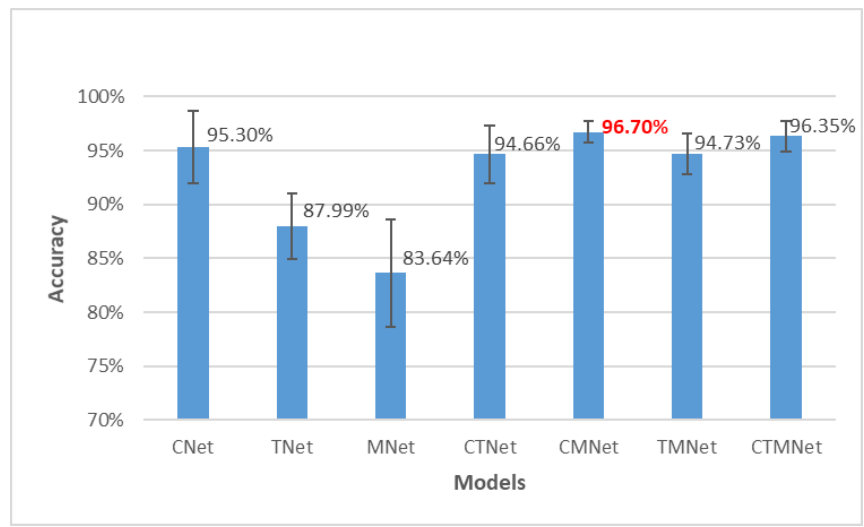
Figure 8. Comparison of the hybrid models in this study.